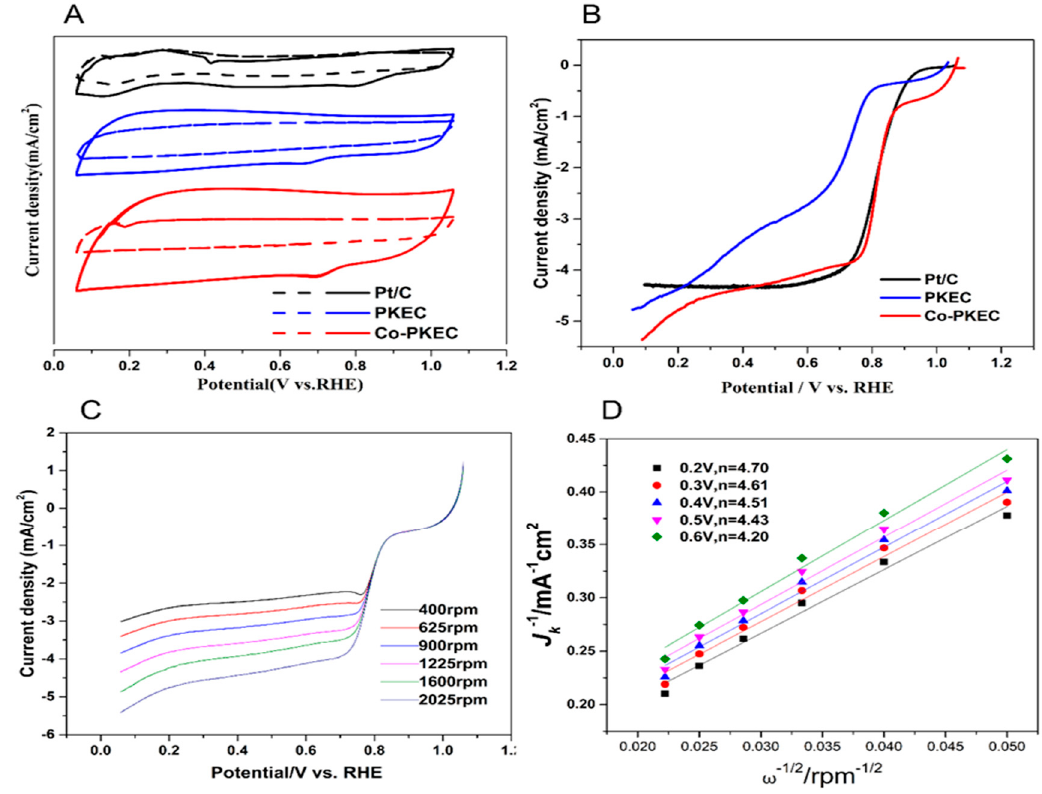
Figure 3. Electrochemical measurements of Co-PKEC on an RDE. ( A ) CV curves of Co-PKEC in O 2 -saturated (solid lines) or N 2 -saturated (dotted lines) 0.1 M KOH aqueous solutions at a scan rate of 100 mV/s. ( B ) LSV curves of Co-PKEC, PKEC and Pt/C in O 2 saturated 0.1 M KOH at a sweep rate of 10 mV/s and rotation speed of 1600 rpm. ( C ) LSV curves of Co-PKEC at various rotation speeds of electrode. ( D ) K-L diagrams at different potentials.